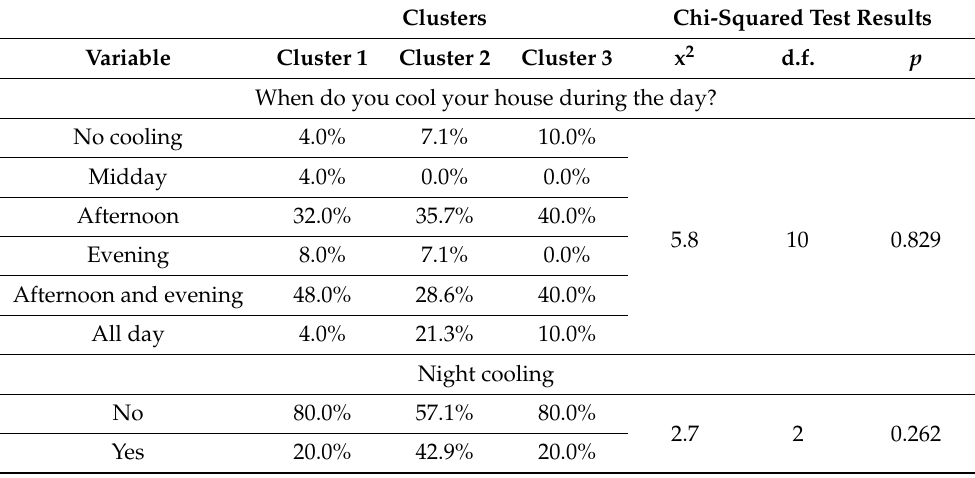
Table 8. Chi-squared analysis of occupant behaviour variables between clusters in summer.